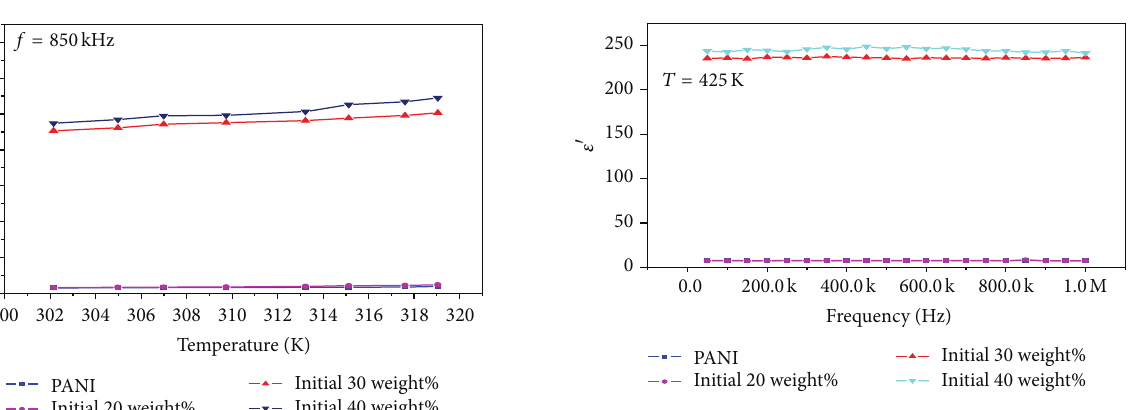
Figure 4: Dielectric constant ( 𝜀 󸀠 ) versus frequency at fixed tem- perature (302K) for pure polyaniline and PANI/V 2 O 5 composites (different weight